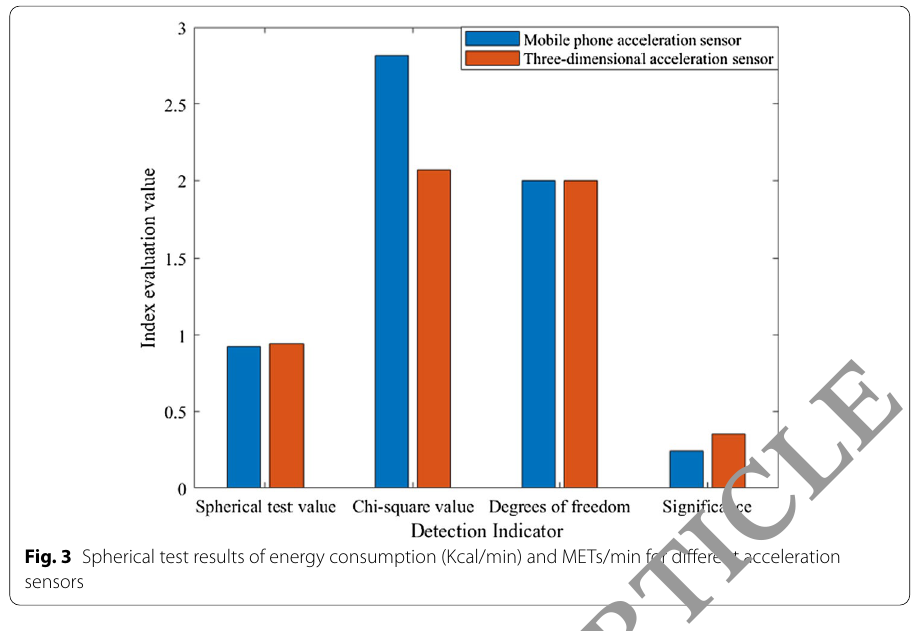
Fig. 3 Spherical test results of energy consumption (Kcal/min) and METs/min for different acceleration